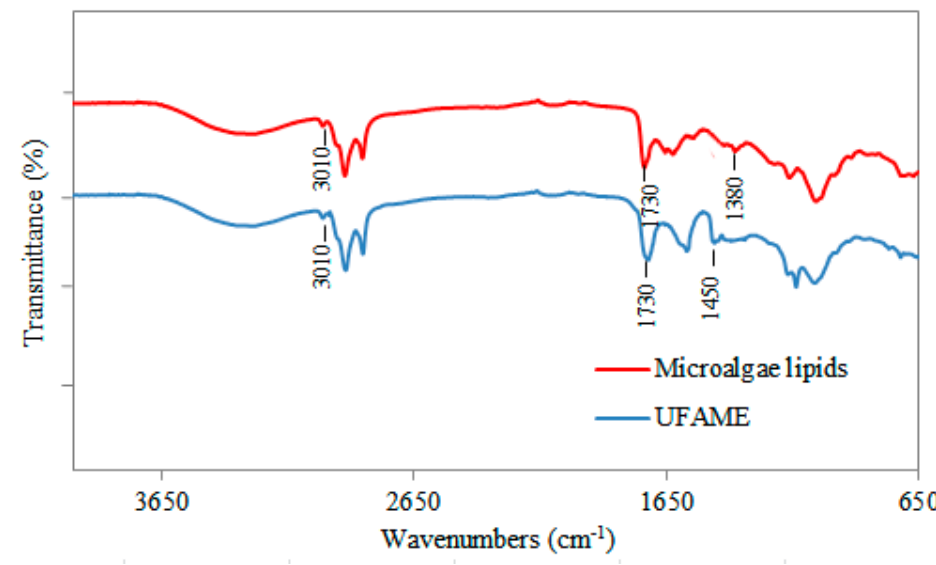
Figure 3. FT-IR spectrum of lipids and UFAME of Chlorella vulgaris microalgae.